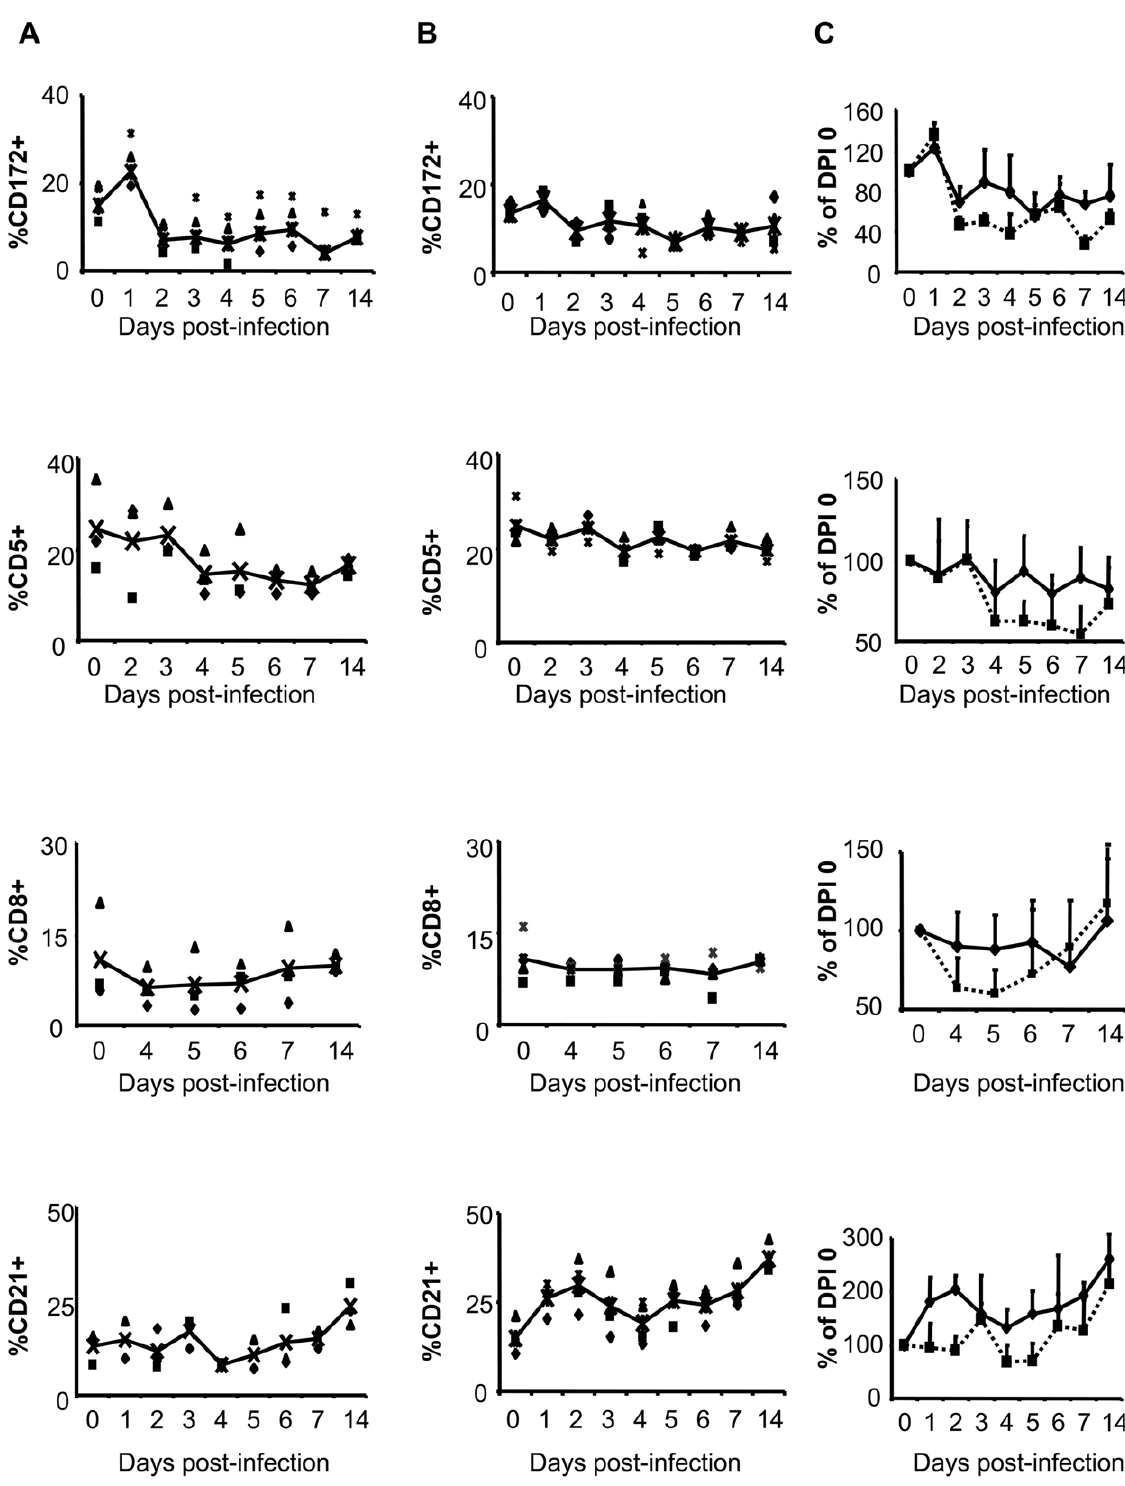
Figure 2. Changes in cell population frequencies in peripheral blood mononuclear cells in RVFV-infected goats. Column A: PBMCs from IN-RVFV-infected goats; Column B: PBMCs from MAM-RVFV-infected goats; Column C: Cell frequencies expressed as a percentage of pre- infection value for — & — IN-RVFV and — ¤ —MAM RVFV- infected goats (n=4 goats each). Data points in column A and B represent individual animals and the line represents the means. In column C data points represent means + standard deviation (error bars). MAM-RVFV=RVFV produced in the mammalian cell line Vero E6, IN-RVFV=RVFV produced in the insect cell line C6/36.